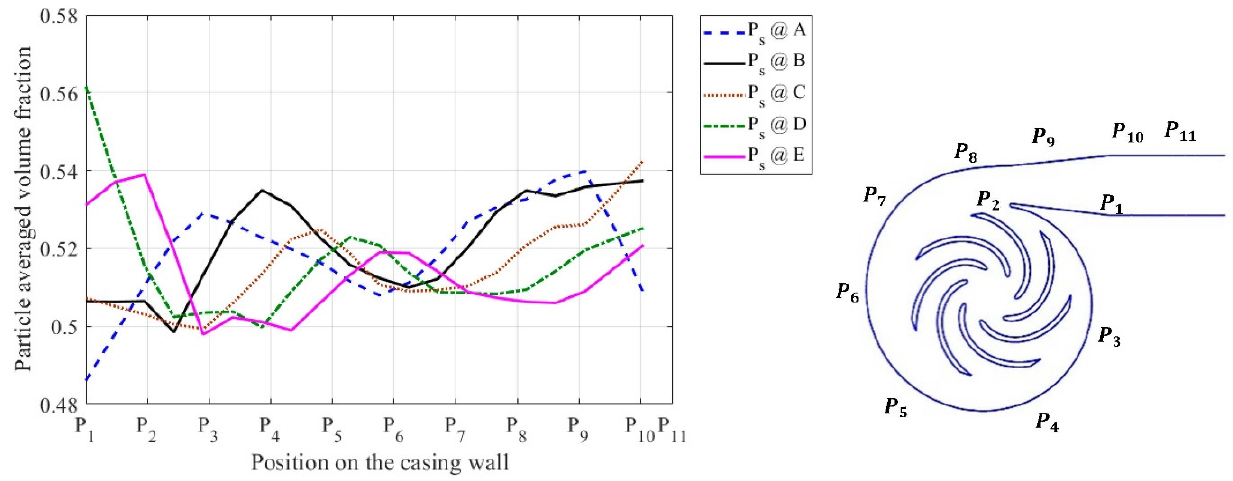
Figure 13. Variation of the concentration of particles along the casing wall with different solid particle sizes and distribu- tion.